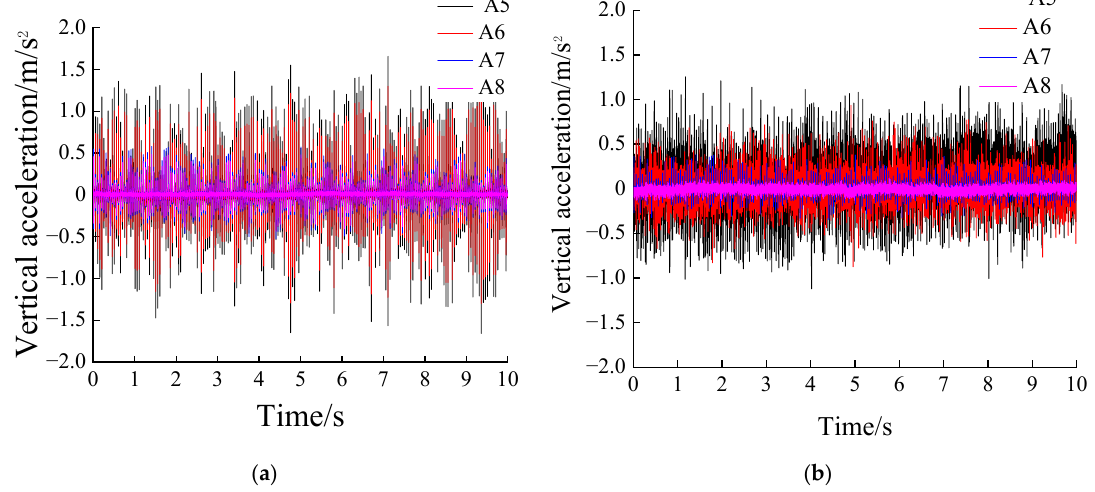
Figure 18. Acceleration time curve of soil measuring points below tunnel invert: ( a ) no base void; ( b ) with base void. Table 6. Peak acceleration of soil layer measuring points (m/s 2 ) .